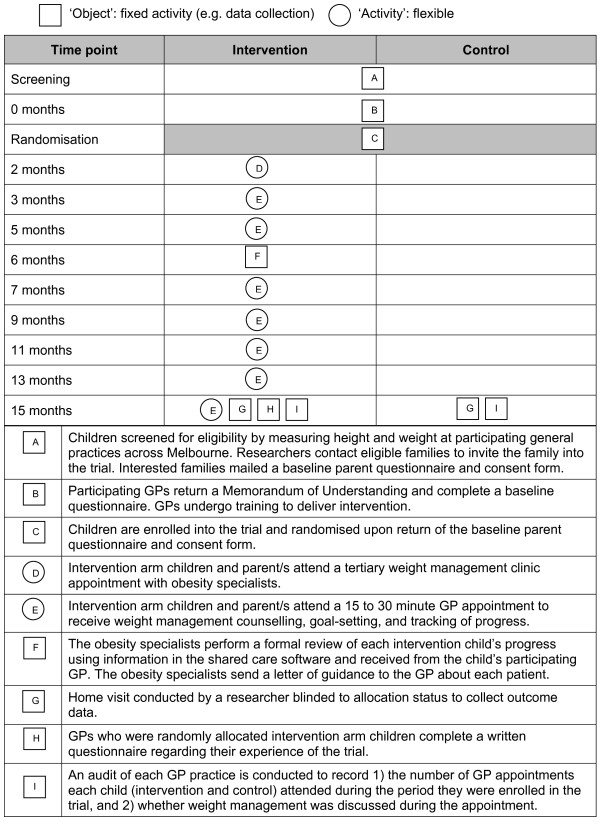
Graphical depiction of components of the HopSCOTCH trial.